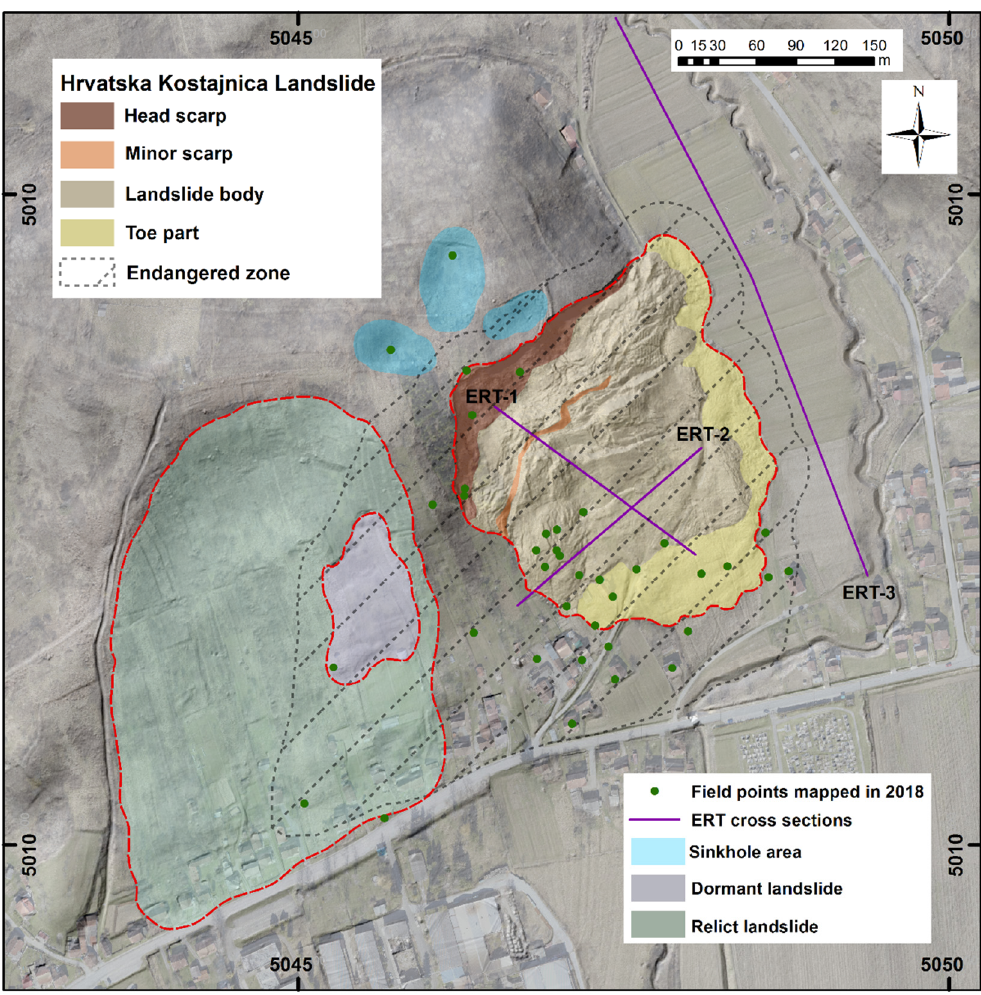
Figure 8. New Hrvatska Kostajnica Landslide Map with marked areas of active, dormant and relict landslide. Landslide areas are depicted with red dashed lines. On the map re-defined area of landslide(s) endangered zone is also marked (grey dashed polygon area).